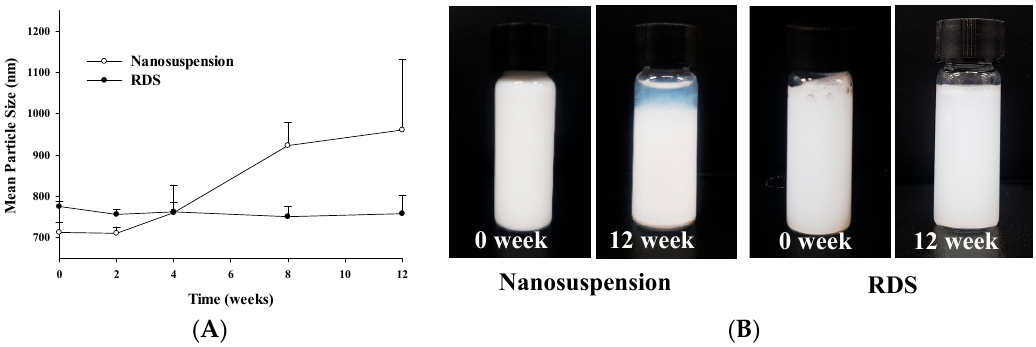
Figure 5. Stability data of nanosuspension and RDS for storage period: ( A ) Mean particle size and ( B ) photographs of physical appearance.